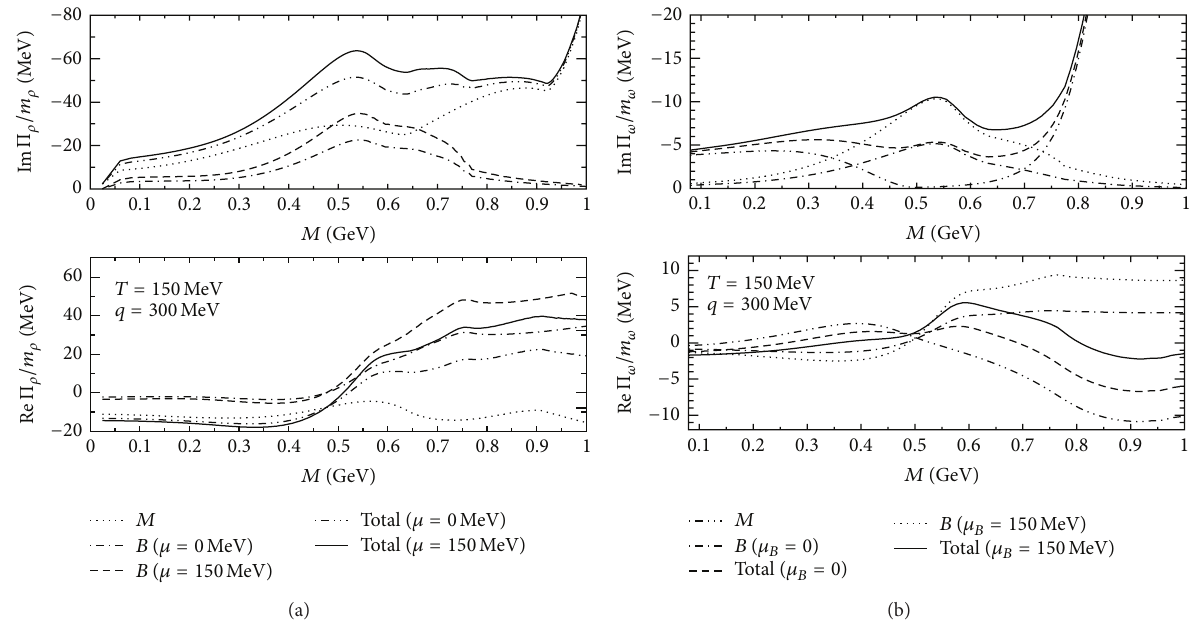
Figure 18: The imaginary (upper) and real (lower) part of self-energy function of 𝜌 (a) and 𝜔 (b) at different chemical potential ( 𝜇 or 𝜇 𝐵 ). The contribution coming from meson, baryon loops, and their sum is shown.